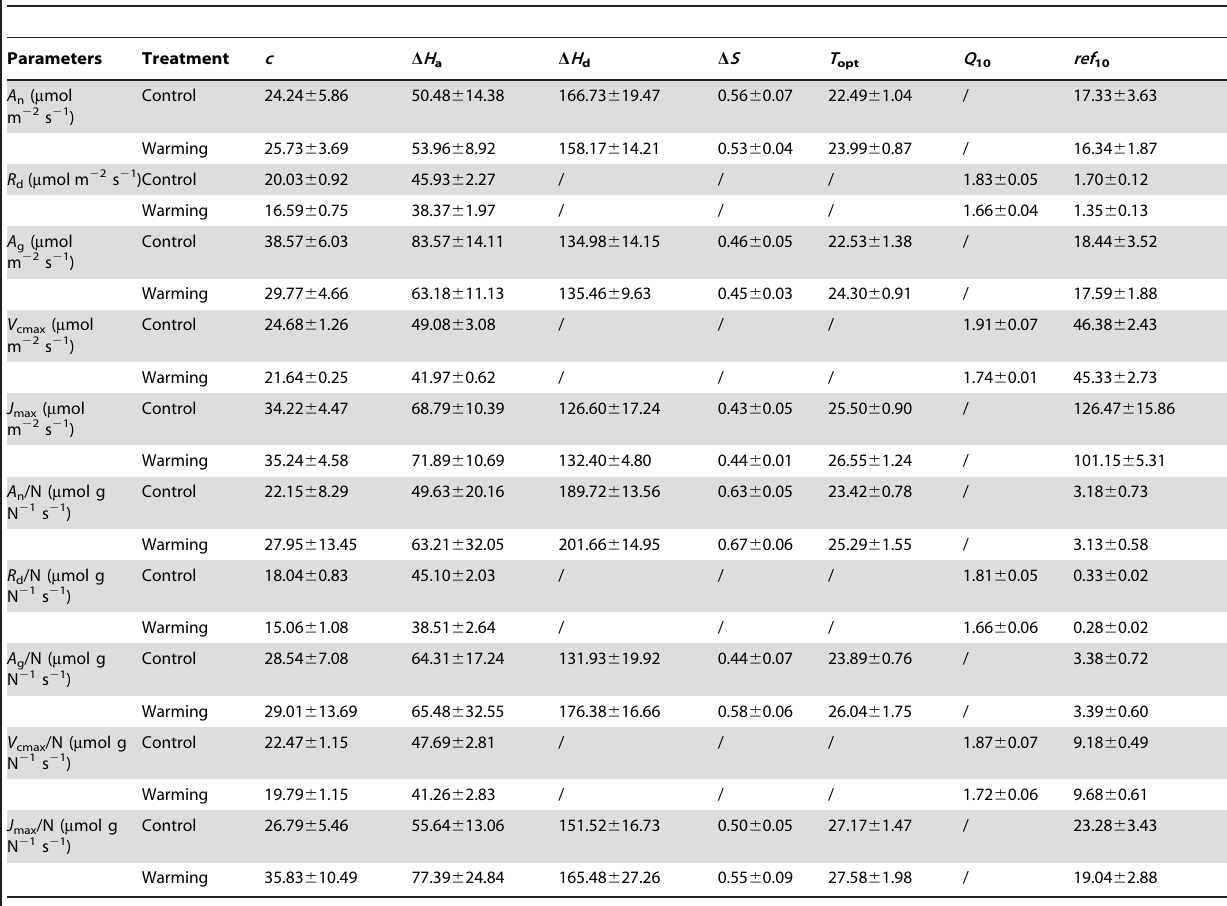
Table 2. Warming effects on the responses of A n (the net CO 2 assimilation rate), R d (dark respiration), A g (the gross CO 2 assimilation rate), V cmax (the maximum rate of Rubisco carboxylation) and J max (the maximum rate of photosynthetic electron transport) expressed per unit foliar area and nitrogen to instantaneous change (10–40 u C within a 5 h period) in T leaf (foliar temperature) in the dry growing season